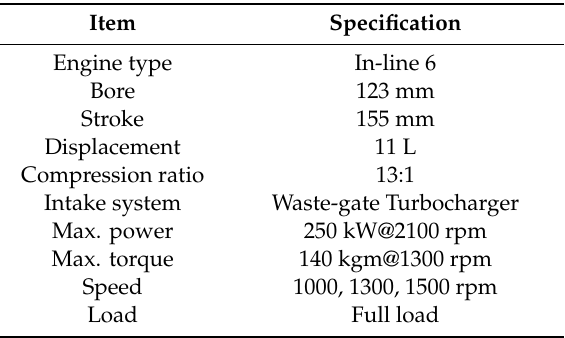
Table 1. Engine specifications and operating